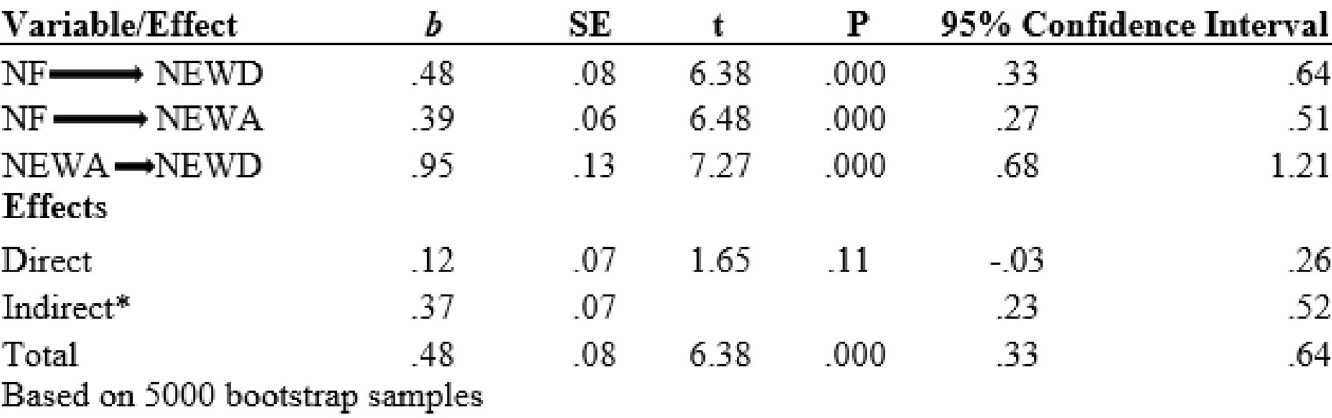
First, the positive correlation between NF and NEWA is consistent with earlier studies. For instance, Craske showed that negative feelings are at the core of different psychopathologies, especially depression and anxiety [38]. Fernandez & Kerns found that negative feelings are pri- marily anger, fear, and sadness, which are key clinical symptoms of anxiety [39]. However, experiencing negative feelings is a risk factor for a poor quality of life and lower resilience among adolescents with congenital physical disabilities [40]. Second, findings revealed that NEWA was significantly and positively associated with NEWD among students with congeni- tal physical disabilities. That is, a higher level of NEWA symptoms among the participants is associated with increased NEWD. Previous studies observed the positive relationship between NEWD and NEWA among children and adolescents with different forms of disability [28, 41] Other studies have demonstrated that NEWA and NEWD co-occur, symptoms of NEWA usu- ally precede the onset of the symptoms of NEWD, and NEWA is a risk factor for NEWD among various samples, including children and adolescents with disability [42, 43].